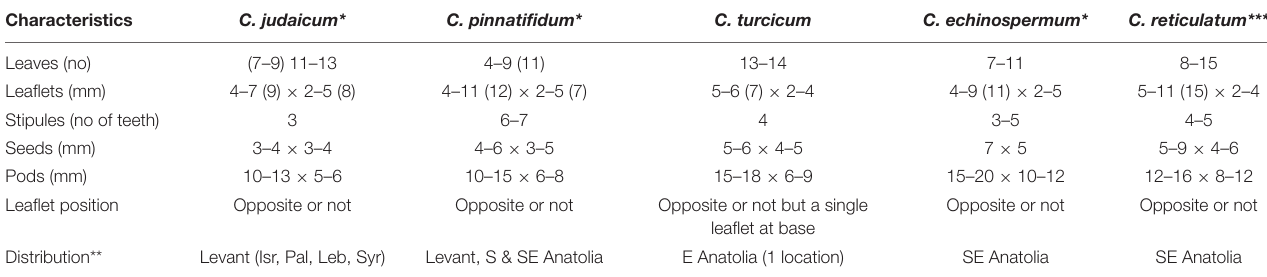
TABLE 5 | Comparison of C. turcicum for diagnostic characteristics with C. pinnatifidum, C. judaicum C. echinospermum , and C. reticulatum . Characteristics